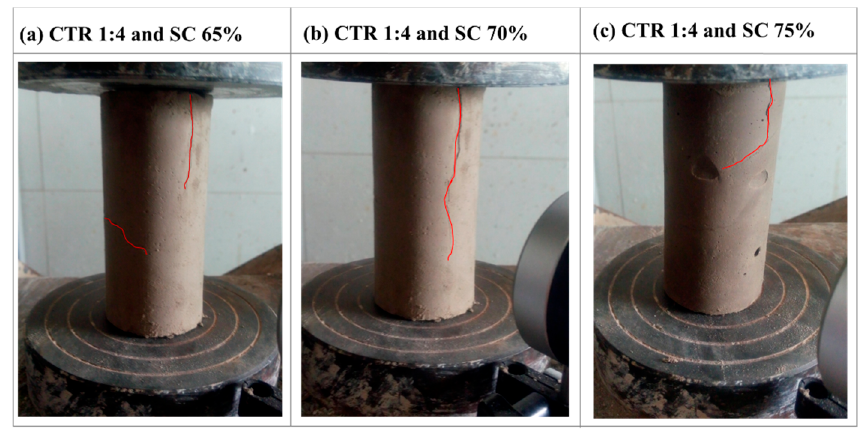
Figure 9. Cracks appeared in the external backfill surface of the CTB-RC specimens with CTR 1:4 and different SC ( a ) 65%, ( b ) 70% and ( c ) 75% during the initial test stage.